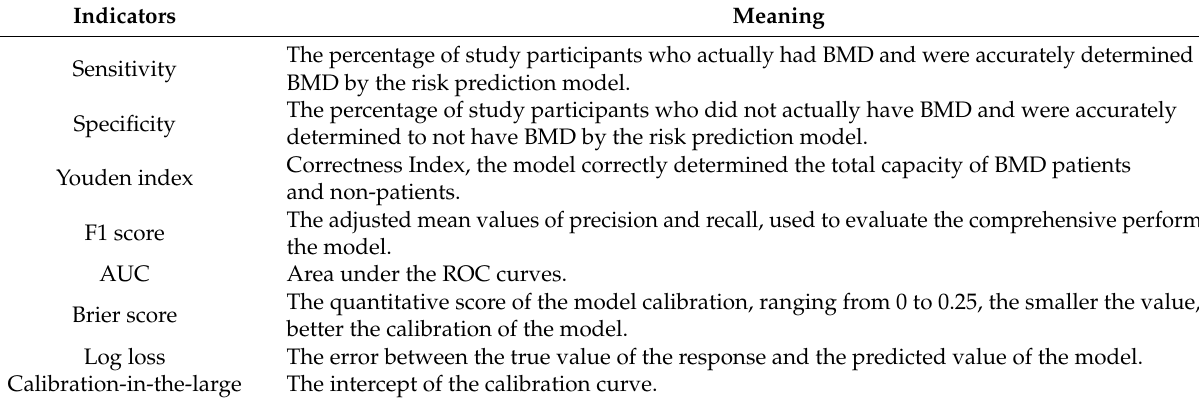
Table 1. Model evaluation